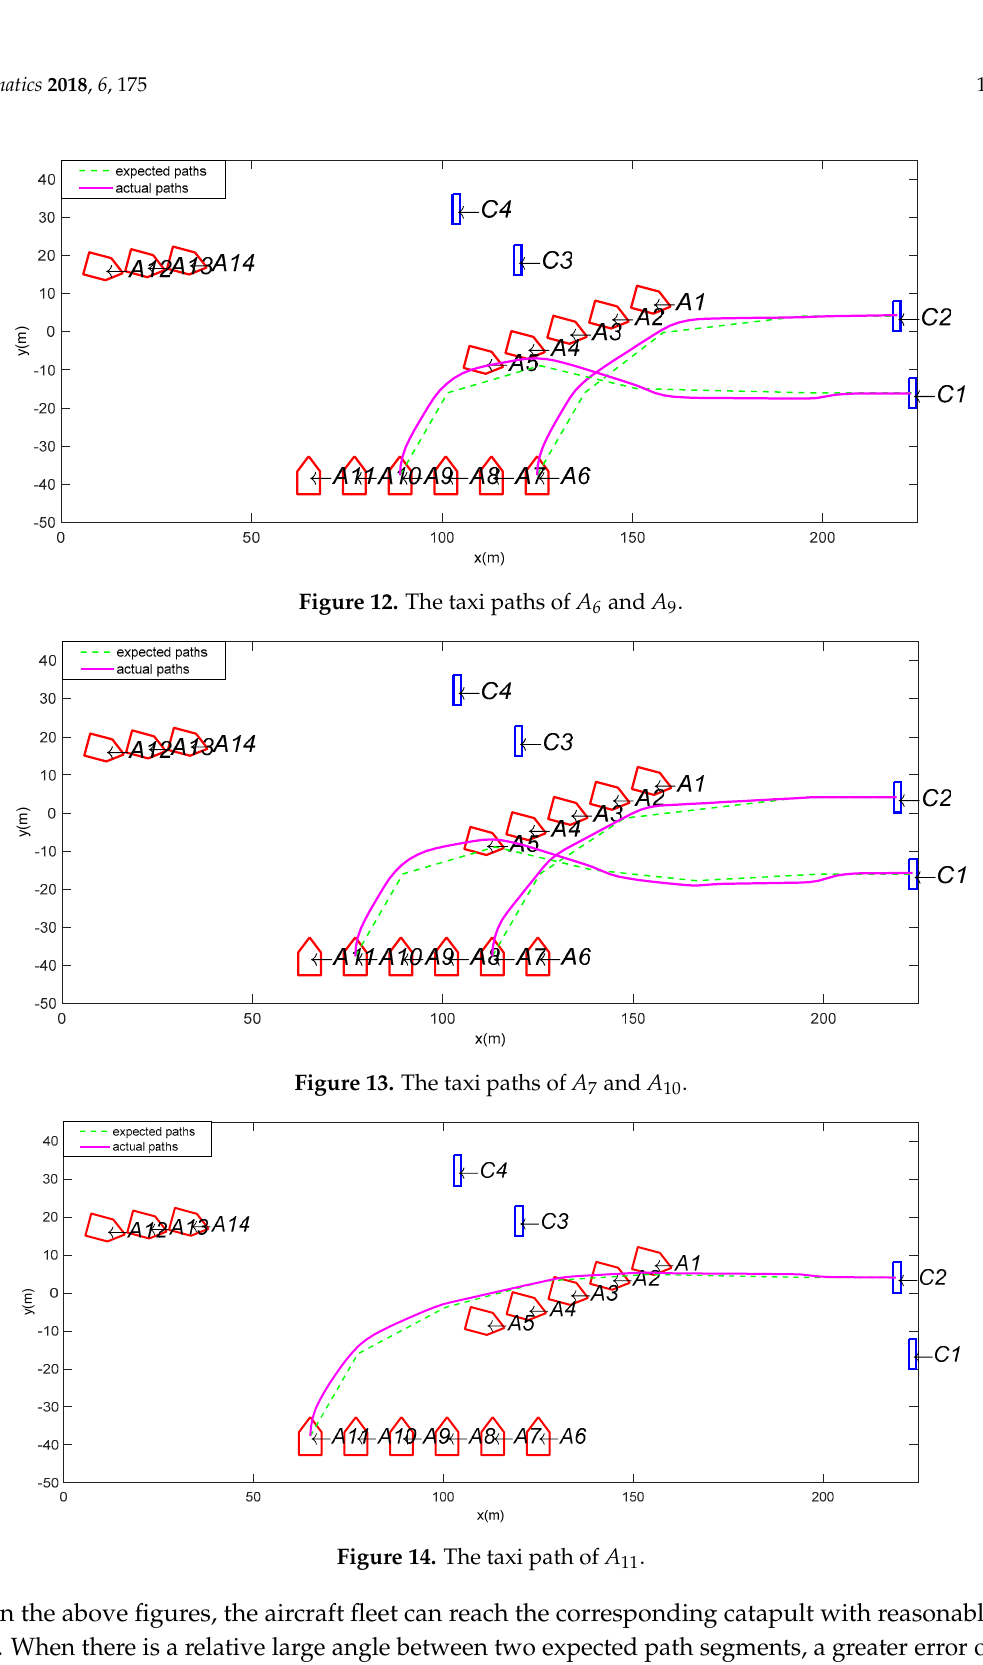
Figure 11. The taxi paths of A 3 , A 8 and A 12.